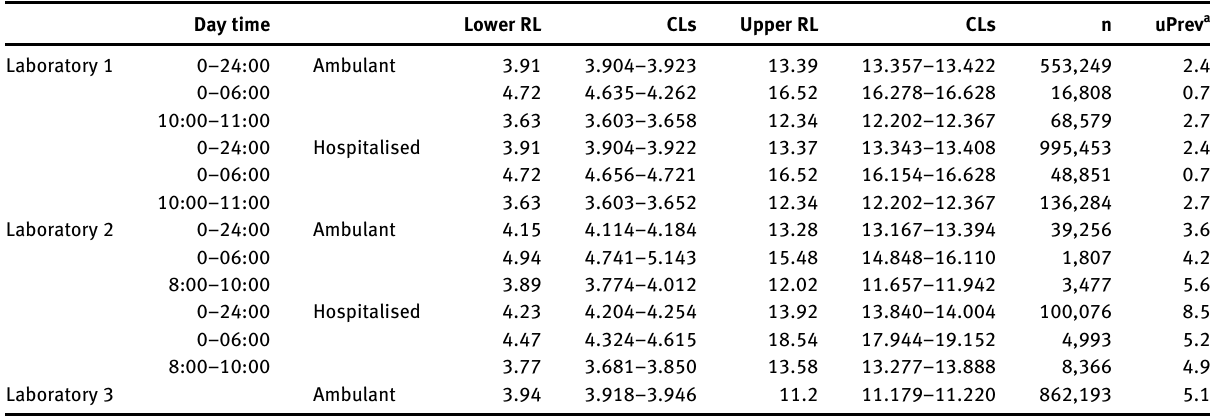
7.07.58.08.59.09.5 Figure 2: Diurnal variation of the leukocyte count in whole venous Figure 1: Reference limits of leukocytes in whole venous blood blood (hospitalised patients, laboratory 1, n=995,453). ( × 10 9 /L) dependent on the age (years). Daily observations are calculated during one week and the medians The upper curves represent the upper reference limits, the lower the from Monday to Friday are presented ( × 10 9 /L). The yellow areas lower reference limits (blue symbols for men, red symbols for represent the approximate 95% con fi dence limits based on the women). The data are from laboratory 3 (n=862,193). median absolute deviation. For hospitalised patients, different upper RLs may be used for samples taken during the morning, and for samples taken during the late afternoon and during night. The time frame depends on the internal organisation of the hospitals. Table  : Reference limits (RLs) with con fi dence limits (CLs) of leukocyte counts ( ×   /L) in whole blood estimated by the truncated minimum chi-square (TMC) approach. The data sets (n, number of data) were of ambulant and hospitalised women and men (  –  years). Day time